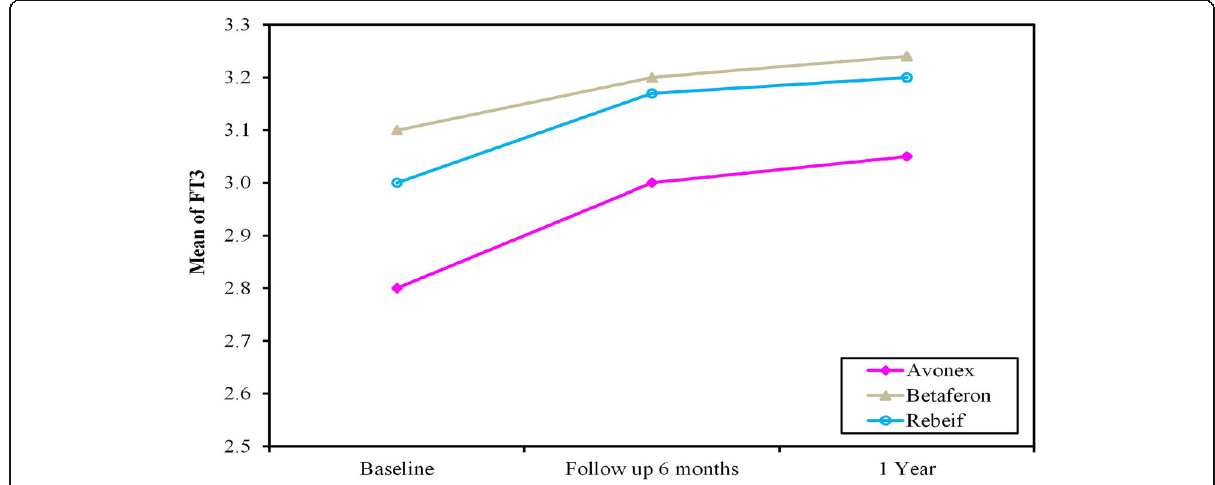
Fig. 4 Comparison between each separate drug groups at baseline, 6-, and 12-month follow-up periods according to FT3